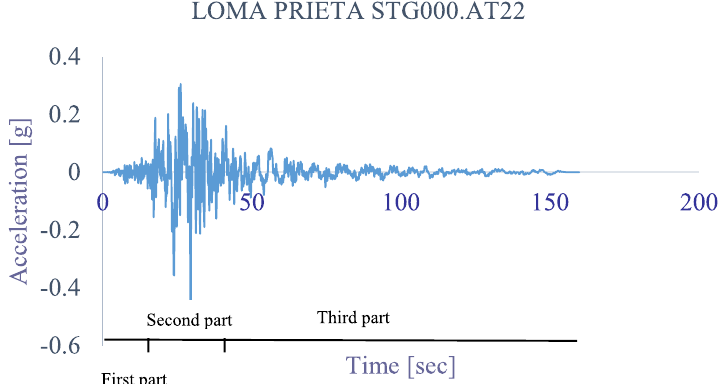
Fig. 6 The record of the horizontal component (STG000) of the Loma Prieta